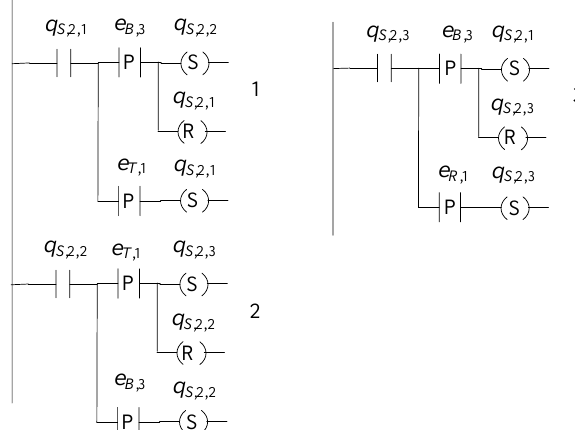
Figure 13. State diagram of S 2